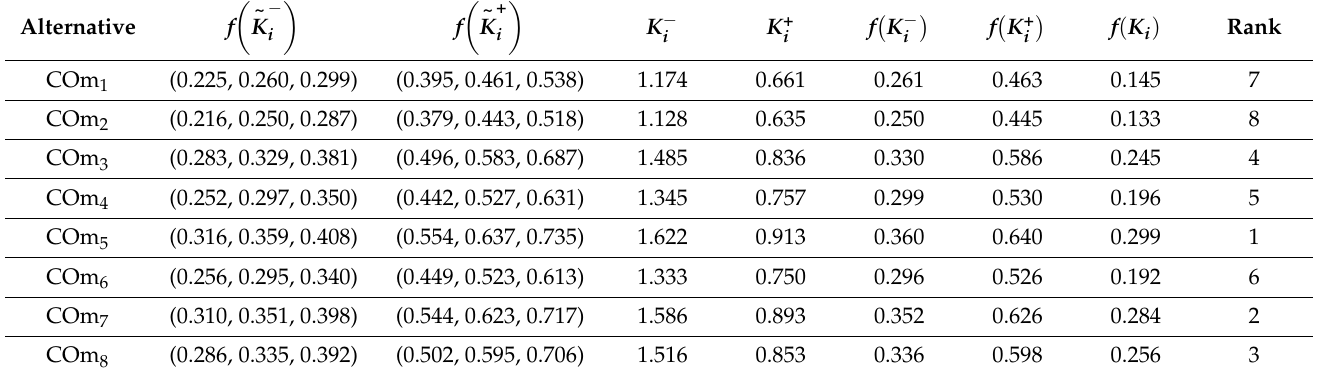
Table 6. Values of utility functions and final ranking of the